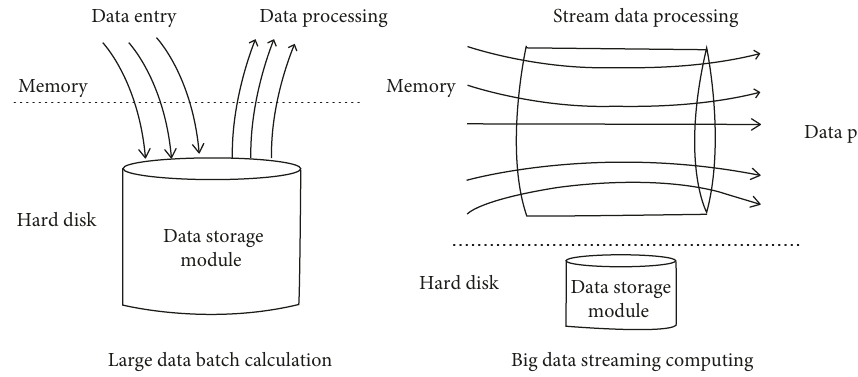
Figure 6: Calculation model of the accounting risk